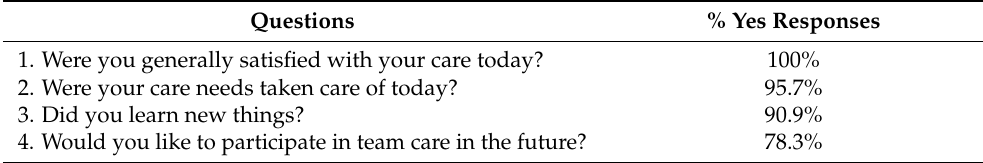
Table 3. Patient satisfaction scores about interprofessional team care